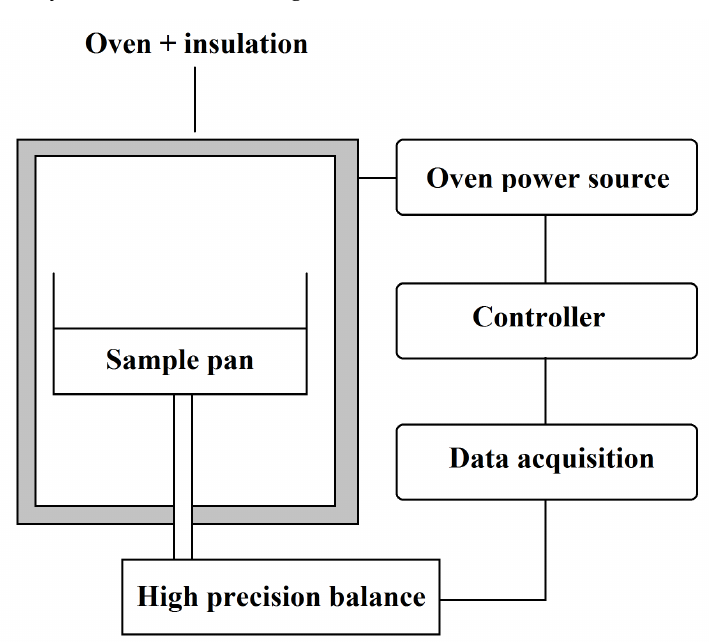
Figure 2. Schematic depiction of a thermogravimetric analyser module. Based on [14,16] and a variety of schemes provided by equipment manufacturers.